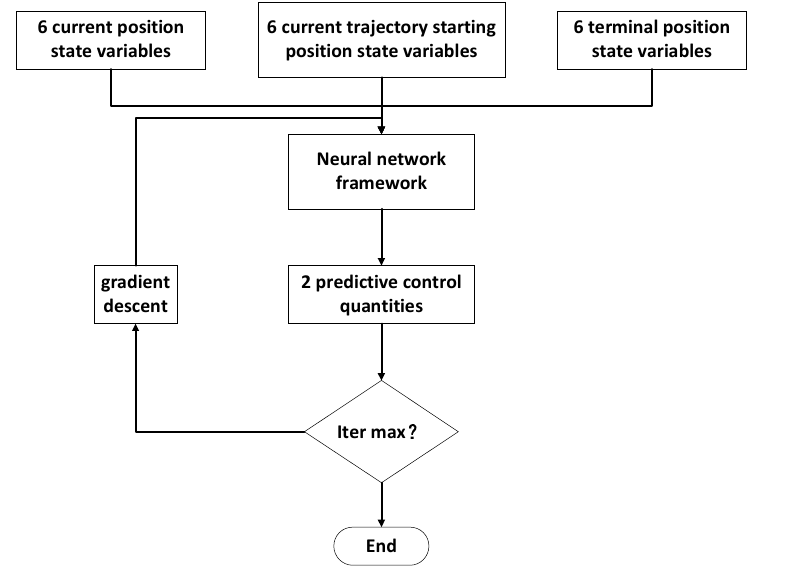
Figure 2. The flowchart of the neural network training process.